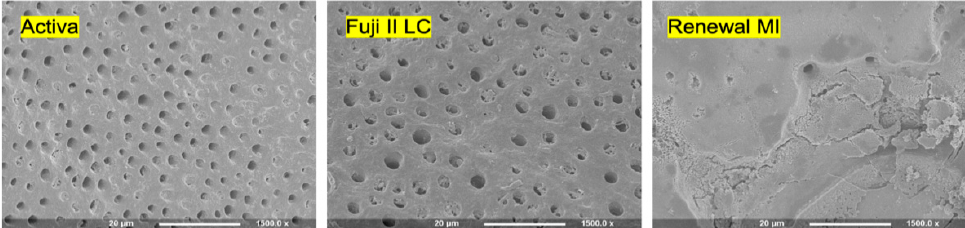
Figure 8. Example SEM images of the collagen mesh discs following their contact with pre-cured Activa, Fuji II LC and Renewal MI discs ( n = 3 per material). Samples were incubated at 37 °C in SBF for 6 months. Activa and Fuji II LC shows widely opened dentinal tubules. Conversely, Renewal MI caused formation of a layer of minerals that covered the whole surface ( n = 3).